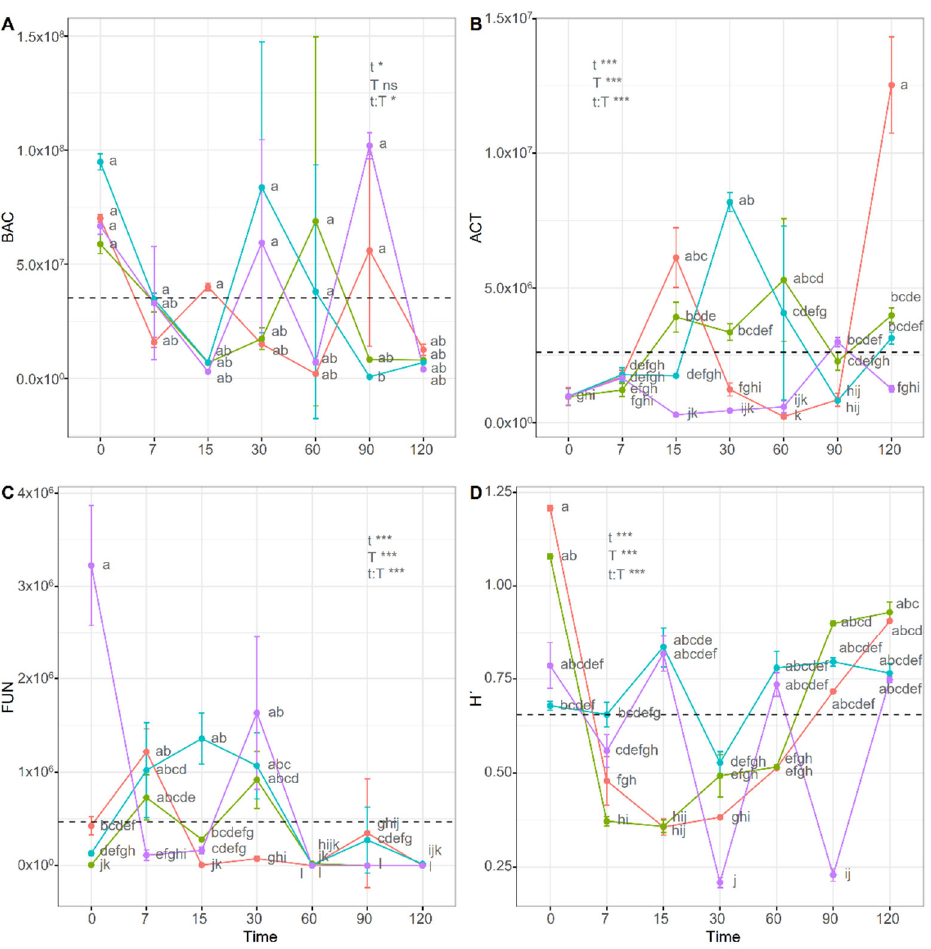
Figure 4. Two-way ANOVA for Shannon index and microbiological indicators of composting systems. Different letters indicate significant differences according to the two-way ANOVA with subsequent Tukey’s test of means at a significance level p ≤ 0.05. Vertical bars represent the standard deviation ( n = 5). ( A ) BAC, bacteria (CFU g − 1 dry compost); ( B ) ACT, actinomycetes (CFU g − 1 dry compost); ( C ) FUN, fungi (CFU g − 1 dry compost); ( D ) H’ , Shannon index. Dotted line represents the mean of the indicator; ns, not significant; *, significant (cid:4666)𝑝 (cid:3409) 0.05 (cid:4667) ; ***, highly significant (cid:4666)𝑝 (cid:3409) 0.001 (cid:4667) .